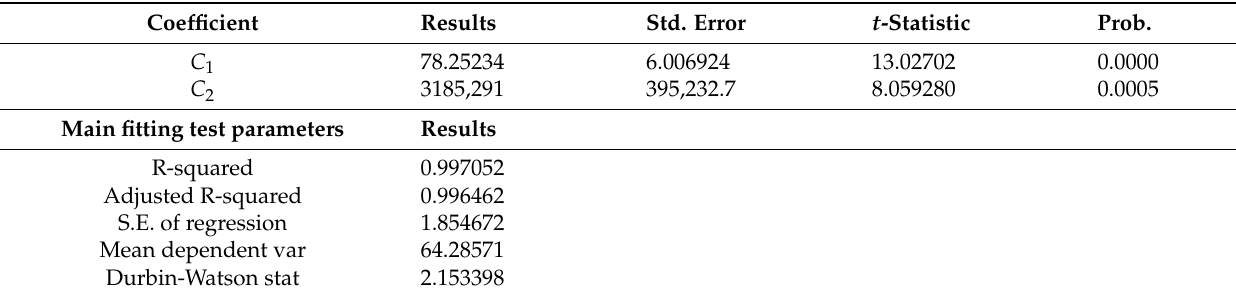
Table 6. The fitting